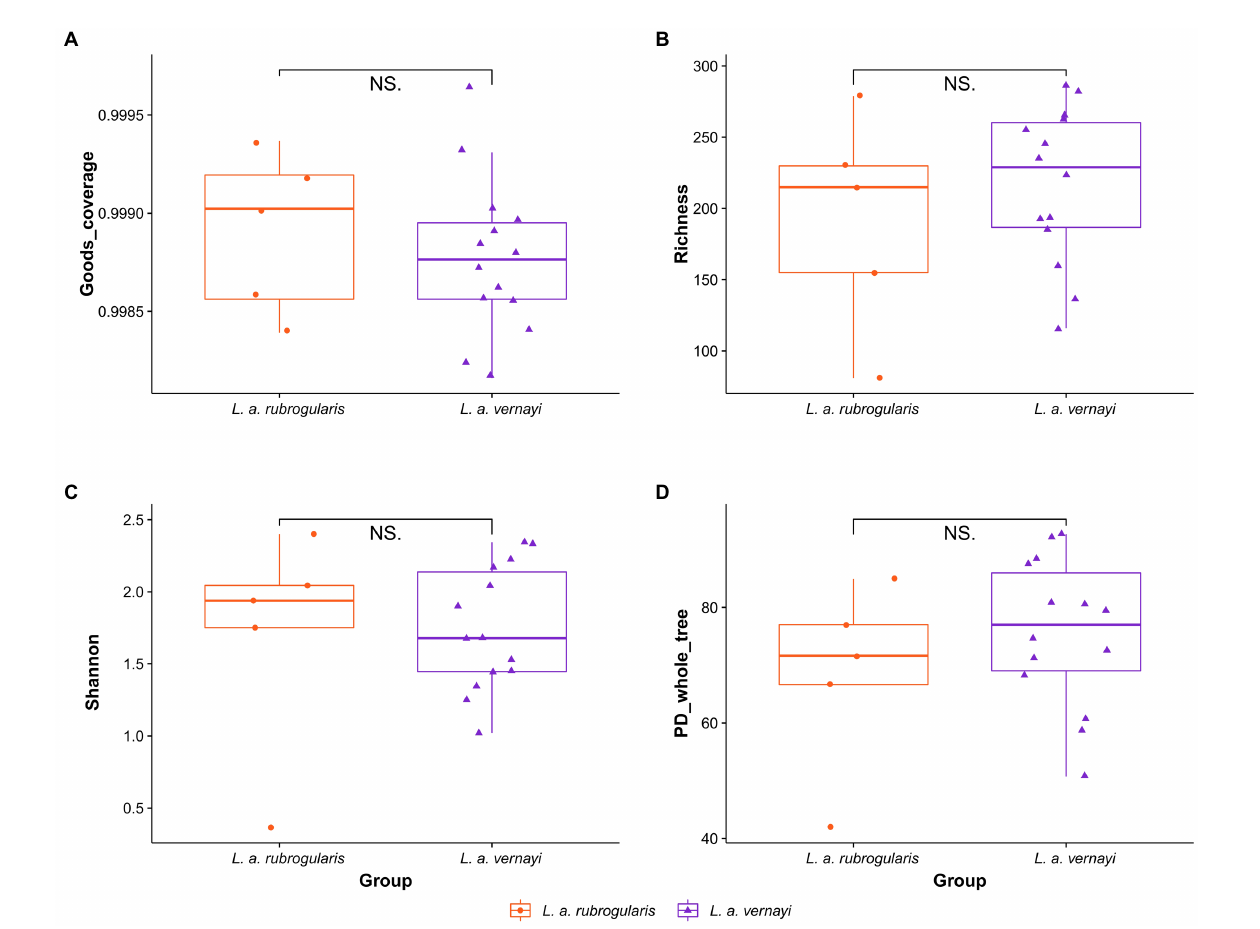
FIGURE 2 Alpha diversity of gut microbiota in the L. a. rubrogularis and L. a. vernayi . (A) Good’s coverage; (B) Richness index; (C) Shannon index; (D) PD_whole_tree. “NS.” showed no significant difference between the two groups ( p > 0.05).